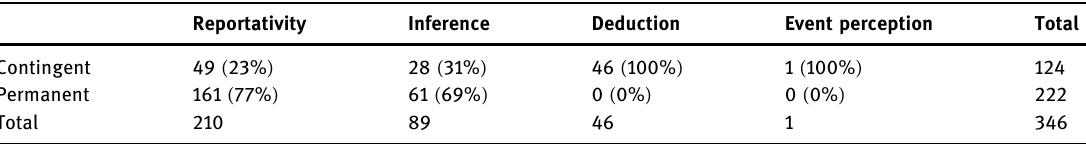
Table 5: Adjectives expressing permanent and contingent properties in the sample